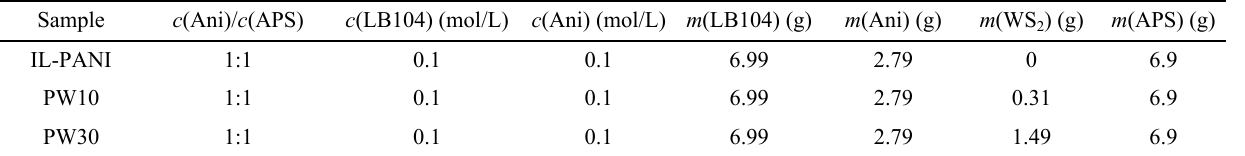
Table 1 Quantity of each substance used in composite synthesis.